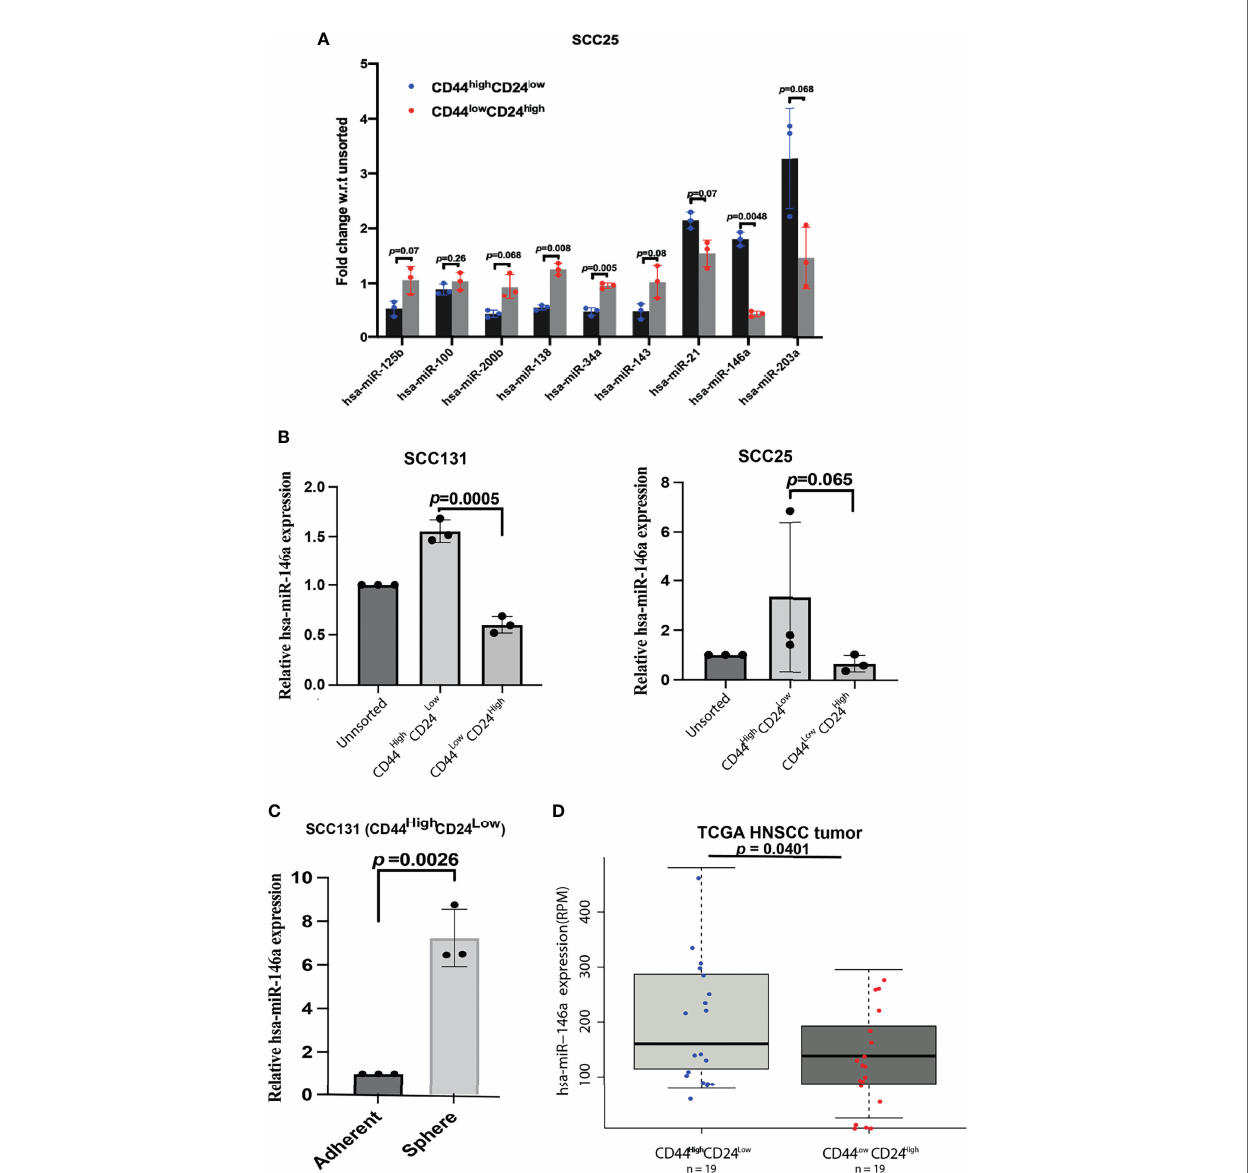
FIGURE 1 | Over-expression of miR-146a in CD44 high CD24 low cells of Oral Squamous Cell Carcinoma. (A) Total RNA extracted from the stem (CD44 high CD24 low ) and the non-stem (CD44 low CD24 high ) sub-populations of SCC25 cells were reverse-transcribed using stem-loop primers speci fi c for subsequent Real time PCR analysis of various miRNAs using respective forward primers and Universal reverse primer ( Supplementary File 1 ). Fold changes w.r.t the unsorted population have been plotted and their adjusted p-values are shown on respective miRNAs (calculated using multiple correction FDR analysis as shown in Supplementary File 2 , Table 2 ). (B) Expression of miR-146a was re-analyzed in UPCI: SCC131 and UPCI: SCC25 by qRT-PCR. Fold change values were plotted and log FC subjected to unpaired t-tests to calculate p -values using GraphPad prism 8. (C) Quanti fi cation of miR-146a transcripts in the spheres enriched from CD44 high CD24 low cells of SCC131 compared to that grown under differentiating adherent conditions. Data is representative of 3 independent experiments and fold change is shown with mean ± SD (p-value calculated on log FC). U6snRNA was used to normalize relative expression values. (D) Box-Scatter plot showing the differential expression of miR-146a in the CD44 high CD24 low and CD44 low CD24 high subgroup of HNSCC tumors obtained from TCGA. (p-value from unpaired t-test was calculated in R package to show statistical signi fi